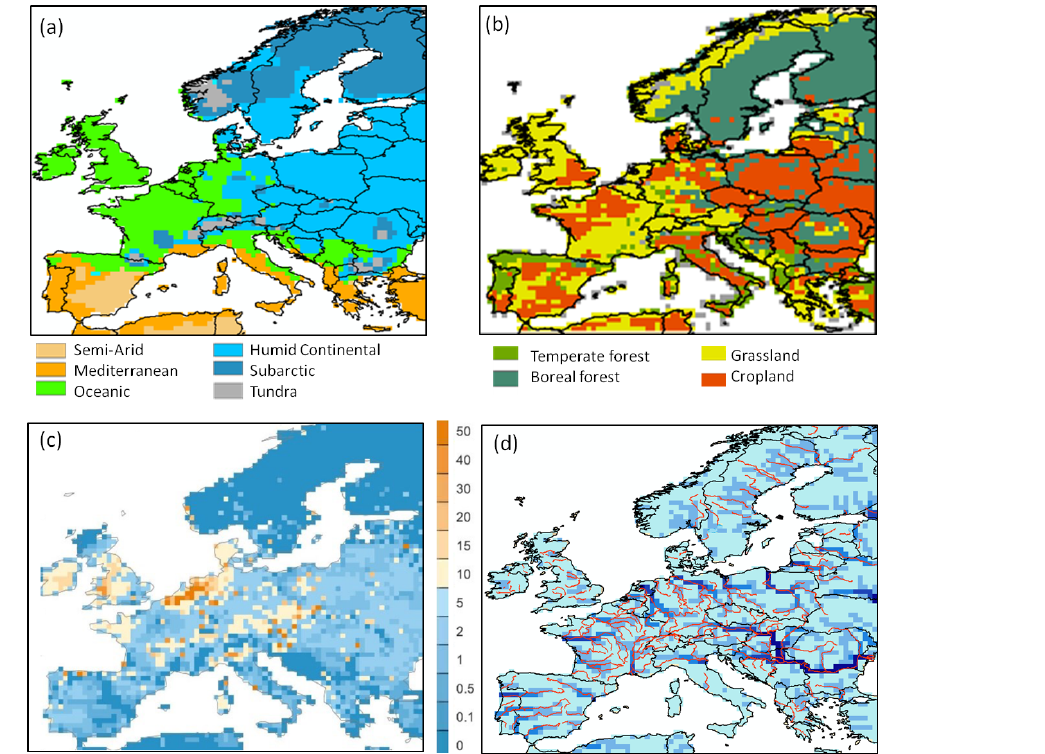
Figure 2. Spatial distribution for each 0.5 ◦ grid cell of the continental European domain of (a) climate zones (according to the Köppen– Geiger classification); (b) dominant plant functional types (PFT); (c) manure application (in gC m − 2 yr − 1 ); (d) the routing network of OR- CHILEAK (in blue). The real river network extracted from the European Environment Agency (https://www.eea.europa.eu/legal/copyright, last access: 3 March 2021) is also